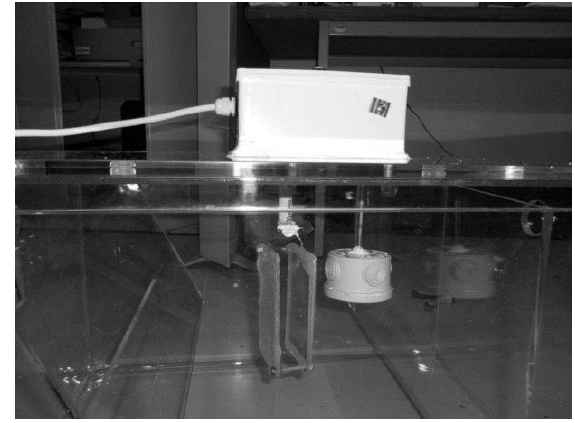
Figure 7. Density measurement with a buoy and a load cell.